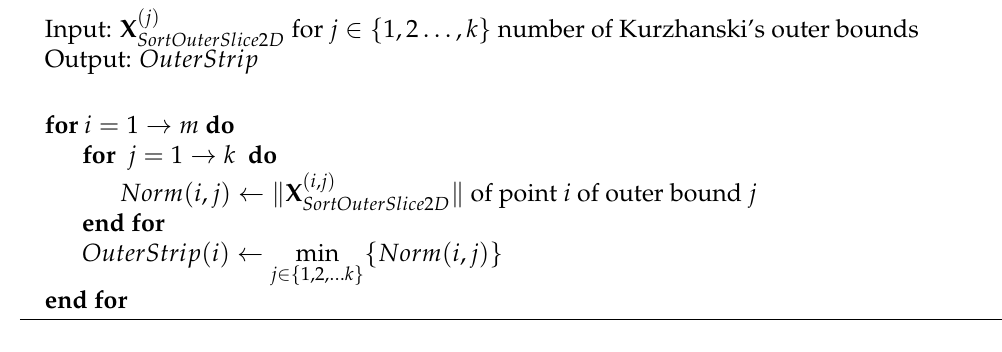
Algorithm A10 Function: Outer layer of a strip of the slice of Minkowski sum